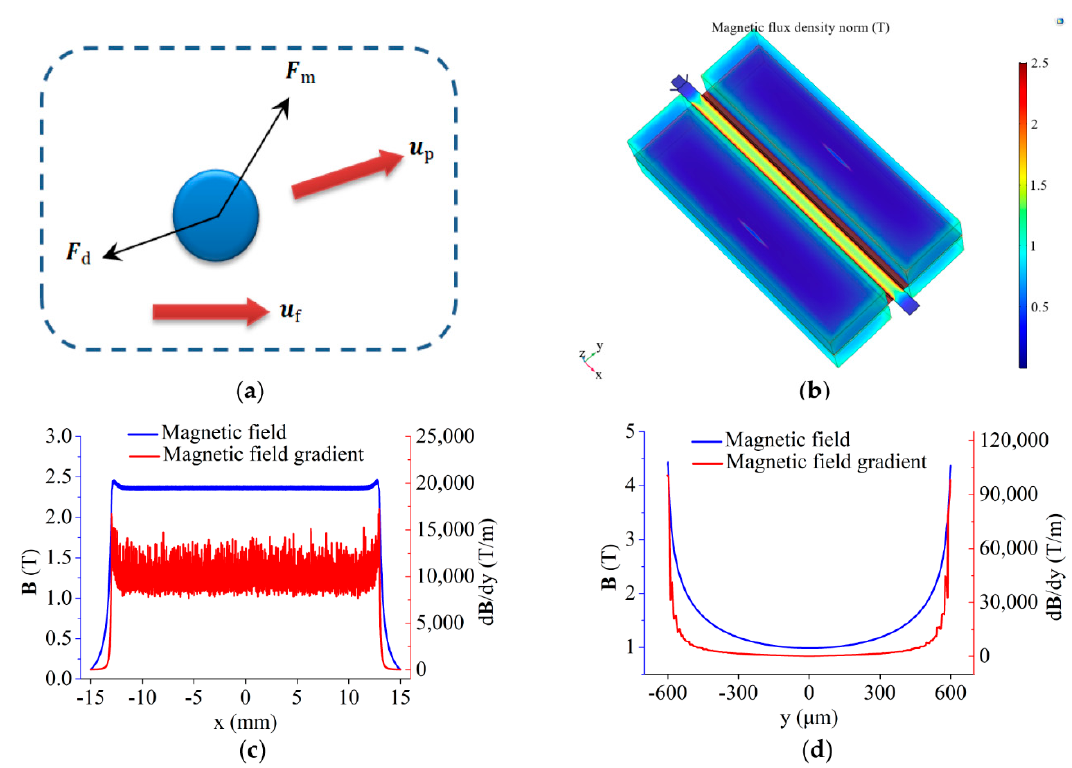
Figure 2. Simulation results of the magnetic field and particle trajectories: ( a ) The force analysis of the particle in separation channel; ( b ) The magnetic field distribution of separation area; ( c ) The magnetic field and its gradient in separation area along x -axis; ( d ) The magnetic field and its gradient in separation area along y -axis.